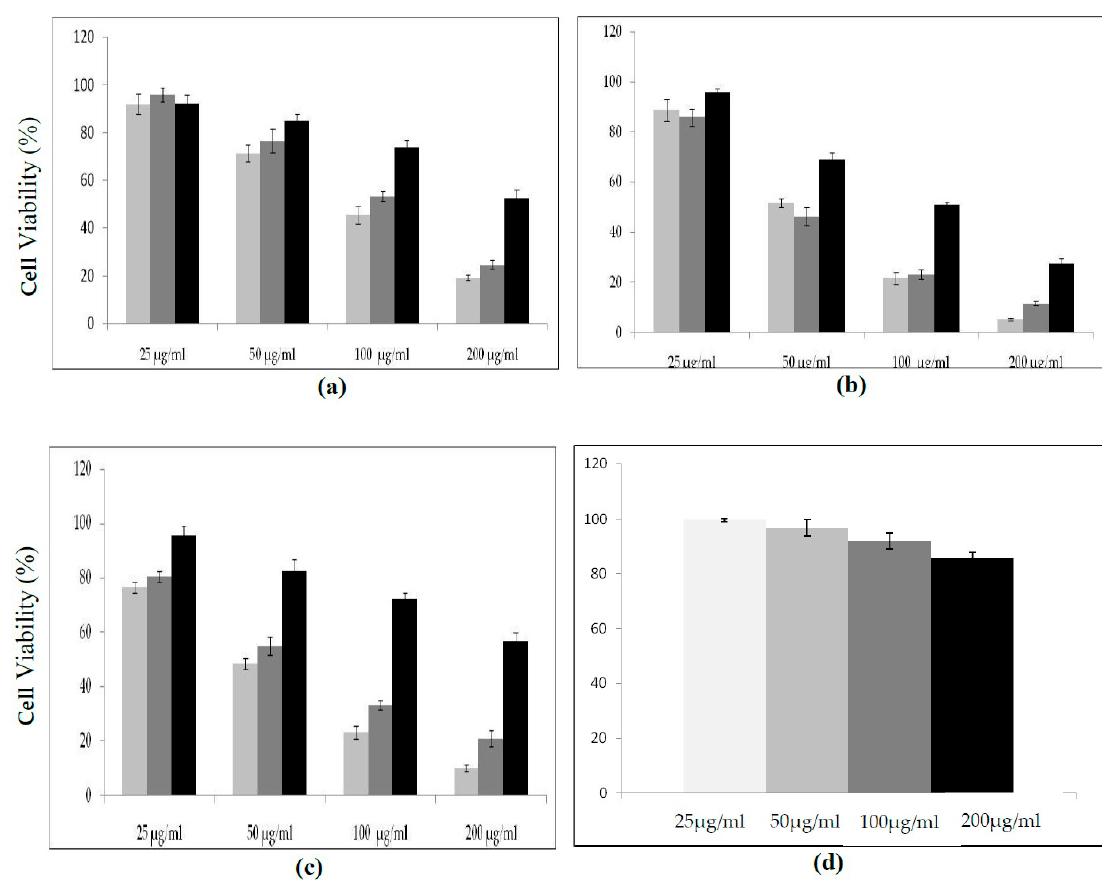
Figure 8. Cytotoxic potency of PDInhibitor in Lovo ( a ), HCT-116 ( b ), and MDA-MB-231 ( c ) cells. Cytotoxicity was assessed using MTT assays by incubating cells for 24 h with various concentrations (25, 50, 100, and 200 µ g) of crude inhibitor from C. dioscoridis (light gray bars), purified inhibitor PDInhibitor (dark gray bars) and pure protease inhibitor from Rhamnus Frangula (black bars), ( d ): Cell viability: HUVEC cells were maintained in culture for 72 h with (25–200 µ g / mL) concentrations of PDInhibitor using MTT solution.